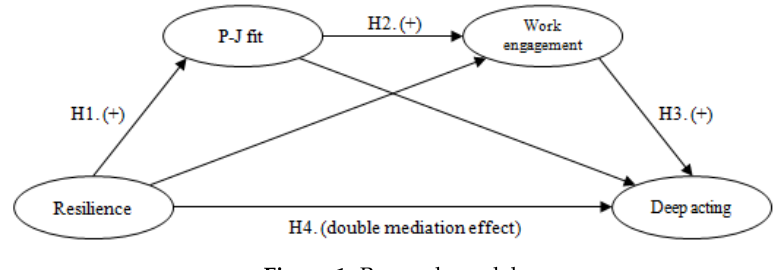
Figure 1. Research model.